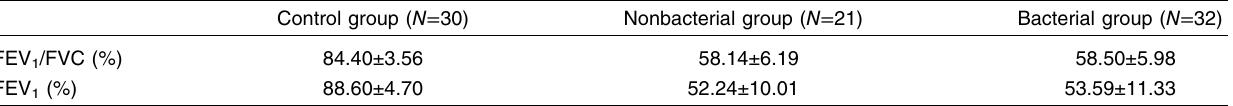
Table 20 Comparison between mean values of FEV 1 /FVC (%) and FEV 1 in the studied